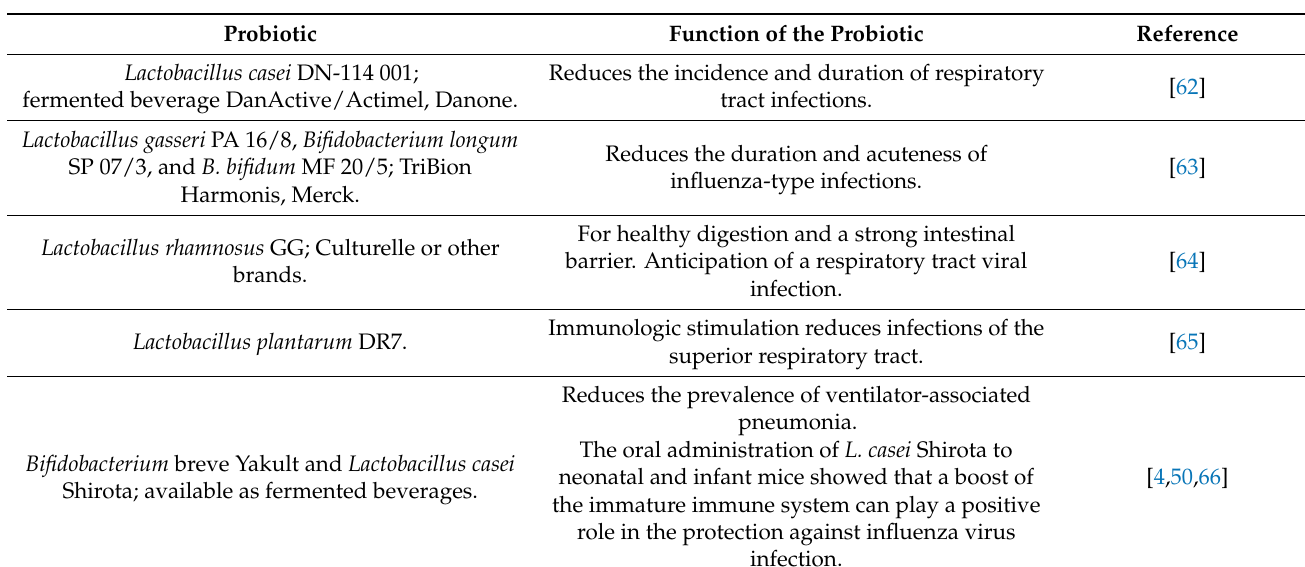
Figure 3. The intestine–lung axis. The regulation of lung immunity by the gastrointestinal microbiota is based on three basic alternatives. The first is the production of antibodies (immunoglobulin A) by activating B cells during the stimulation of the immune system by commensal intestinal bacteria. The second is the activation of T cells, stimulated by the dendritic cells interacting with commensal intestinal bacteria. The third is the generation of bacterial metabolites by the intestinal microbiota. All three can pass by the lymphatic system and reach the lungs, where they can generate responses against respiratory pathogens. Table 1. Probiotics studied in humans that might contribute to decrease respiratory tract infection